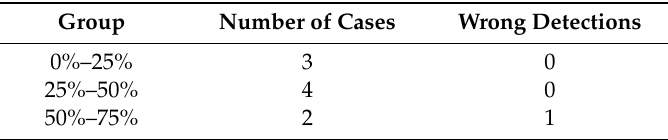
Table 8. Results of the incomplete operations detection.